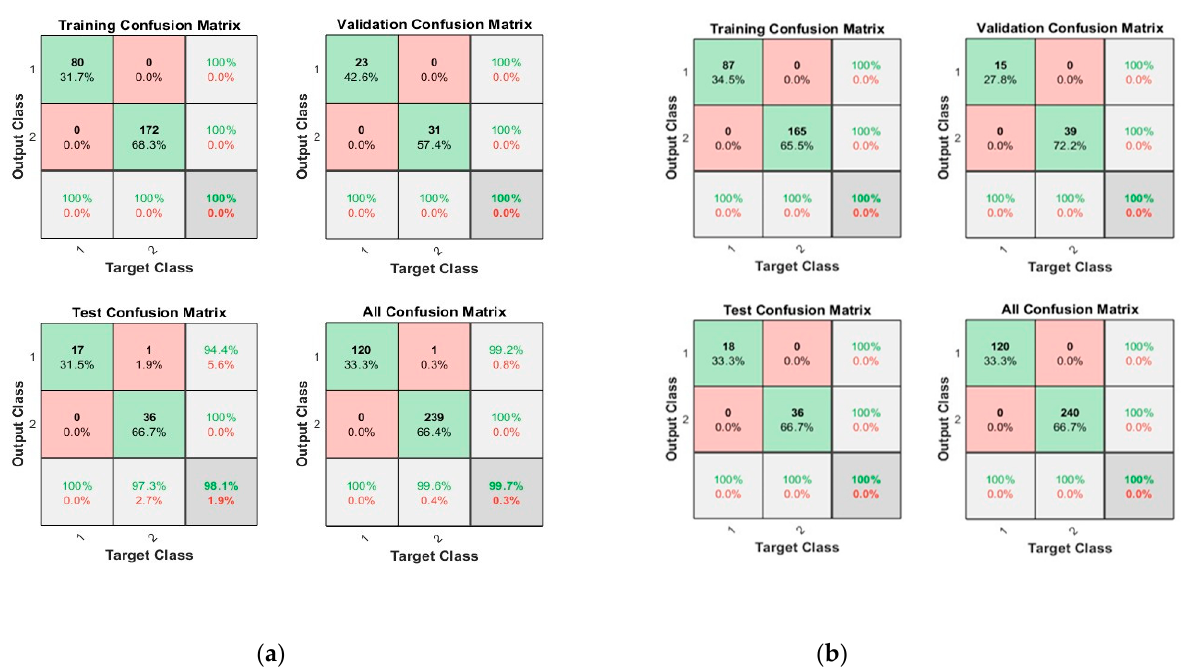
Figure 8. The convergence of the neural network for Dataset-2. ( a ) 10 Neurons and ( b ) 50 Neurons in the hidden layers.